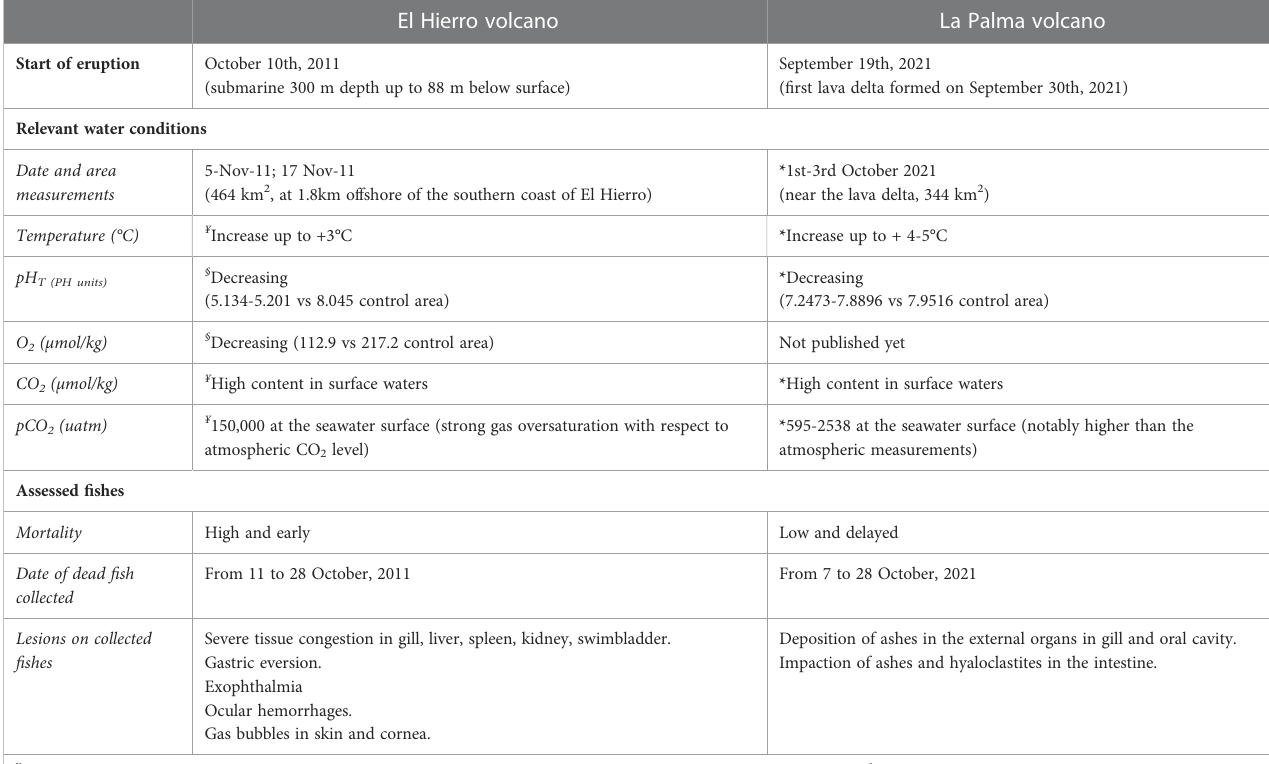
TABLE 3 Summary of the most signi fi cant oceanographic data together with the main lesions described for the two different volcanic